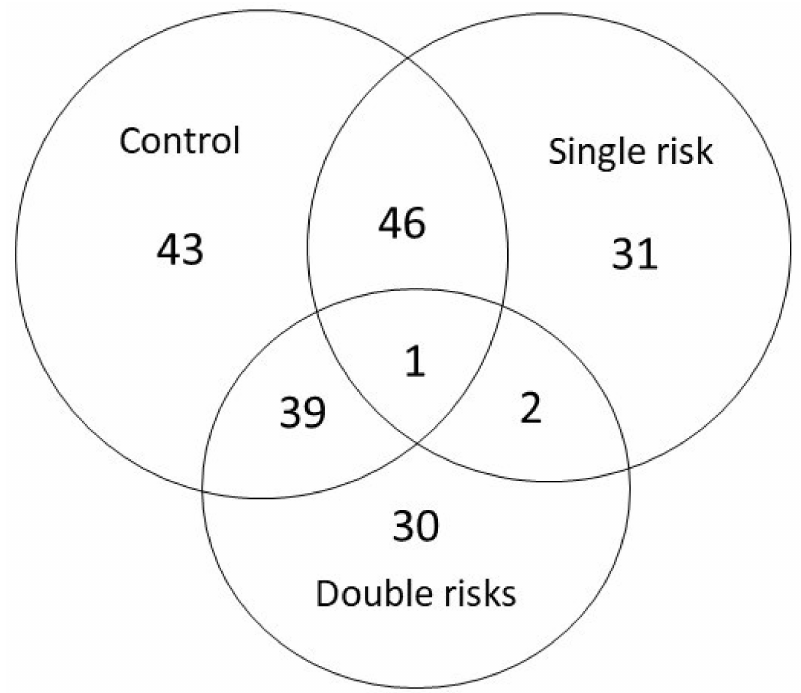
Figure 2. Label-free Nanoflow UHPLC-MS/MS analytical workflow for the proteomic analysis of human aqueous humor. Samples were digested using trypsin and were analyzed using an LTQ-Orbitrap DiscoveryTM hybrid mass spectrometer (Thermo Electron). Proteins were identified and quantified using the SEQUEST algorithm followed by analysis using Xcalibur 2.0 SR1 (Thermo Electron). The intersection of each area represents the number of significant expression ( p < 0.05) proteins between each groups. Only one protein was significantly deferentially expressed in each